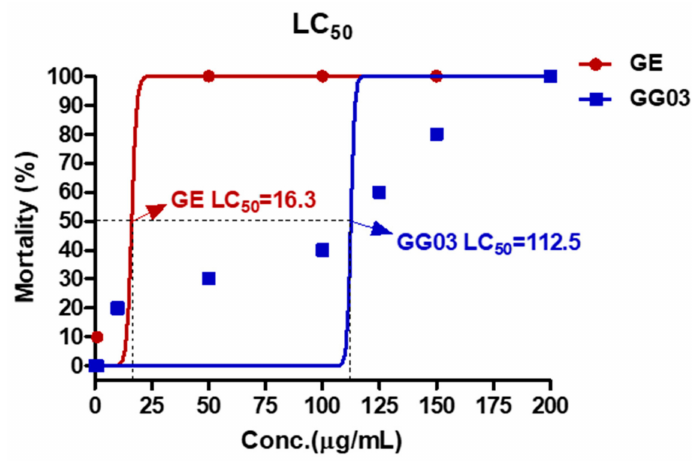
Figure 3. LC 50 of zebrafish embryos exposed to GE and GG03 for 72 h. The LC 50 of GE was 16.3 µ g / mL. The LC 50 of GG03 was 112.5 µ g /